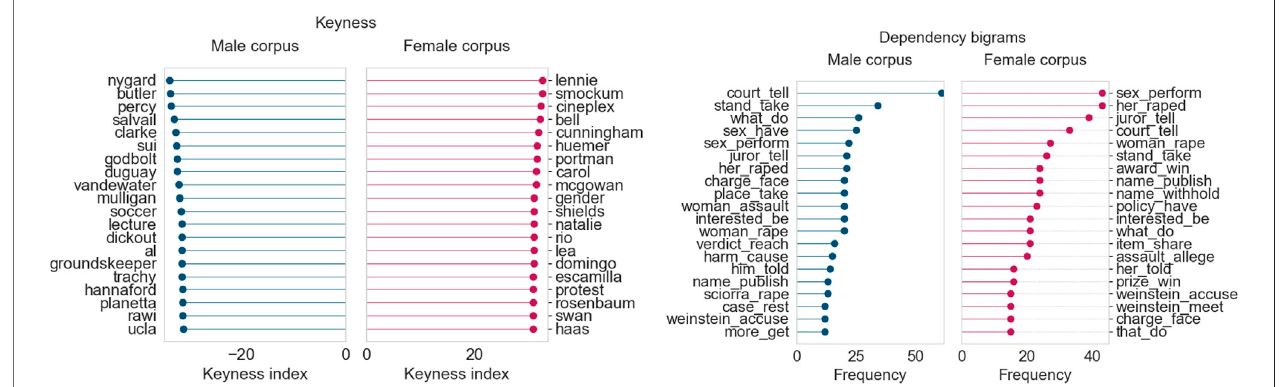
FIGURE 12 | Corpus analysis results for top 200 articles from “ Crimes and sexual assault ” (February